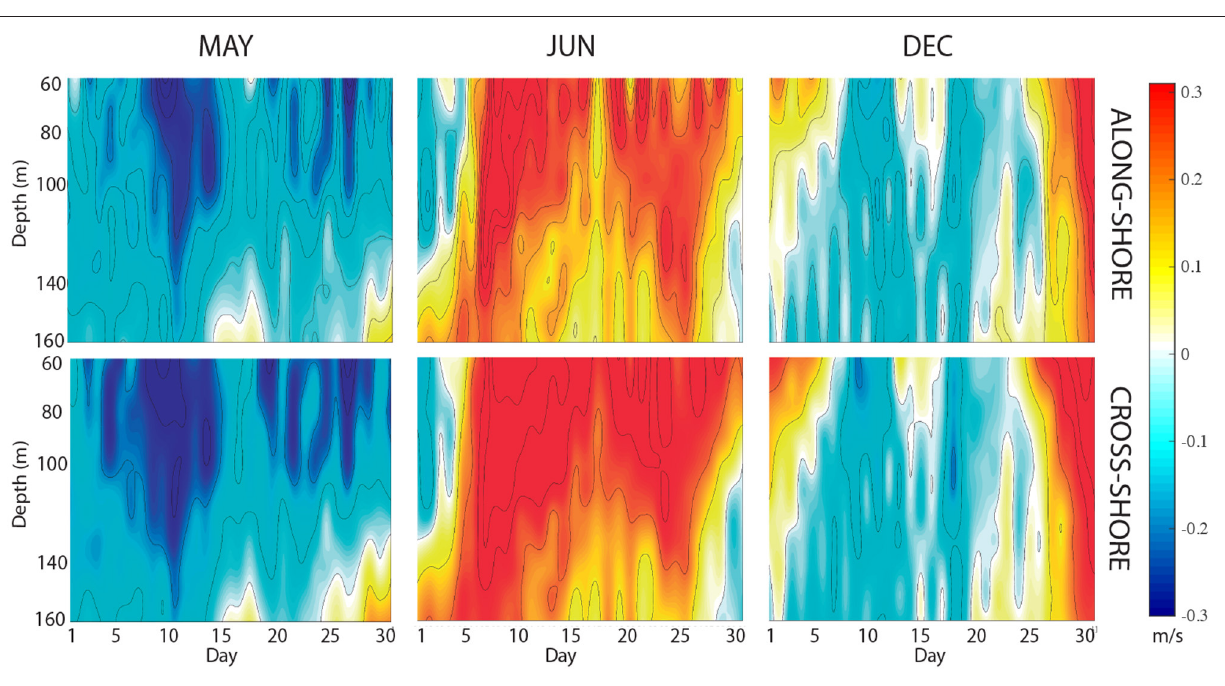
ADCP1 measurements taken off Santa Marta ( Figure 5 ), during May along-shore velocities are directed northeastward while cross-shore velocities are onshore (southeastward), suggesting